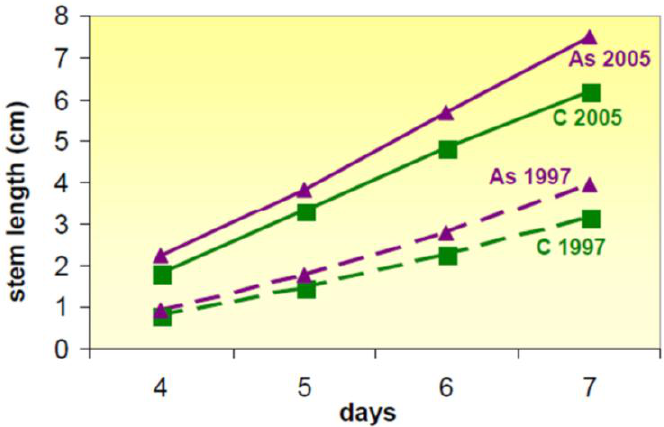
FIGURE 5. Time trend of the effect on the stem length of As 45x (As) vs. control (C); comparison between the original trial (1997, dotted line) and second trial (2005, continuous line). C is represented by squares and As by